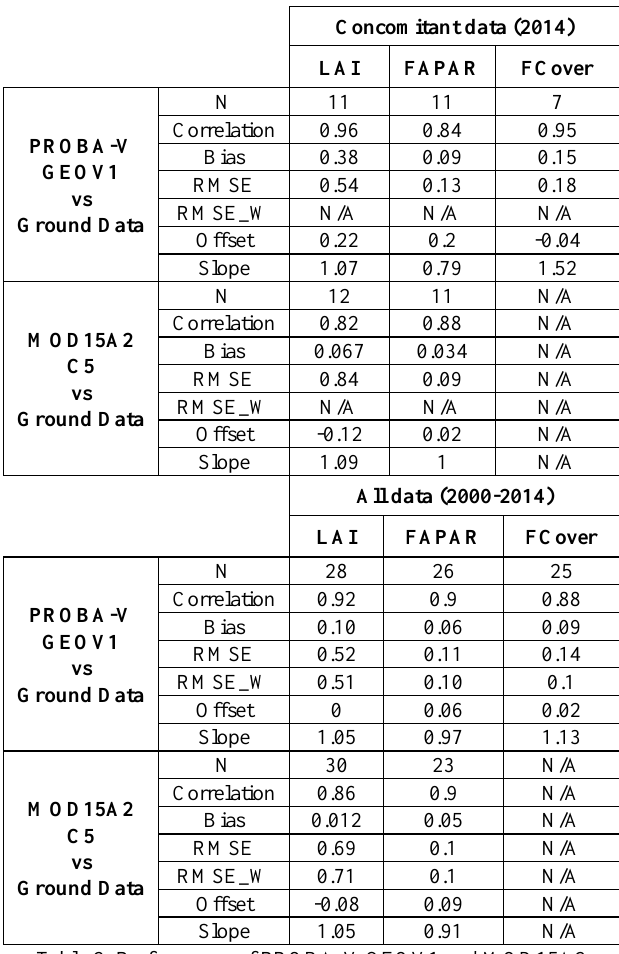
Concomitant data (2014)